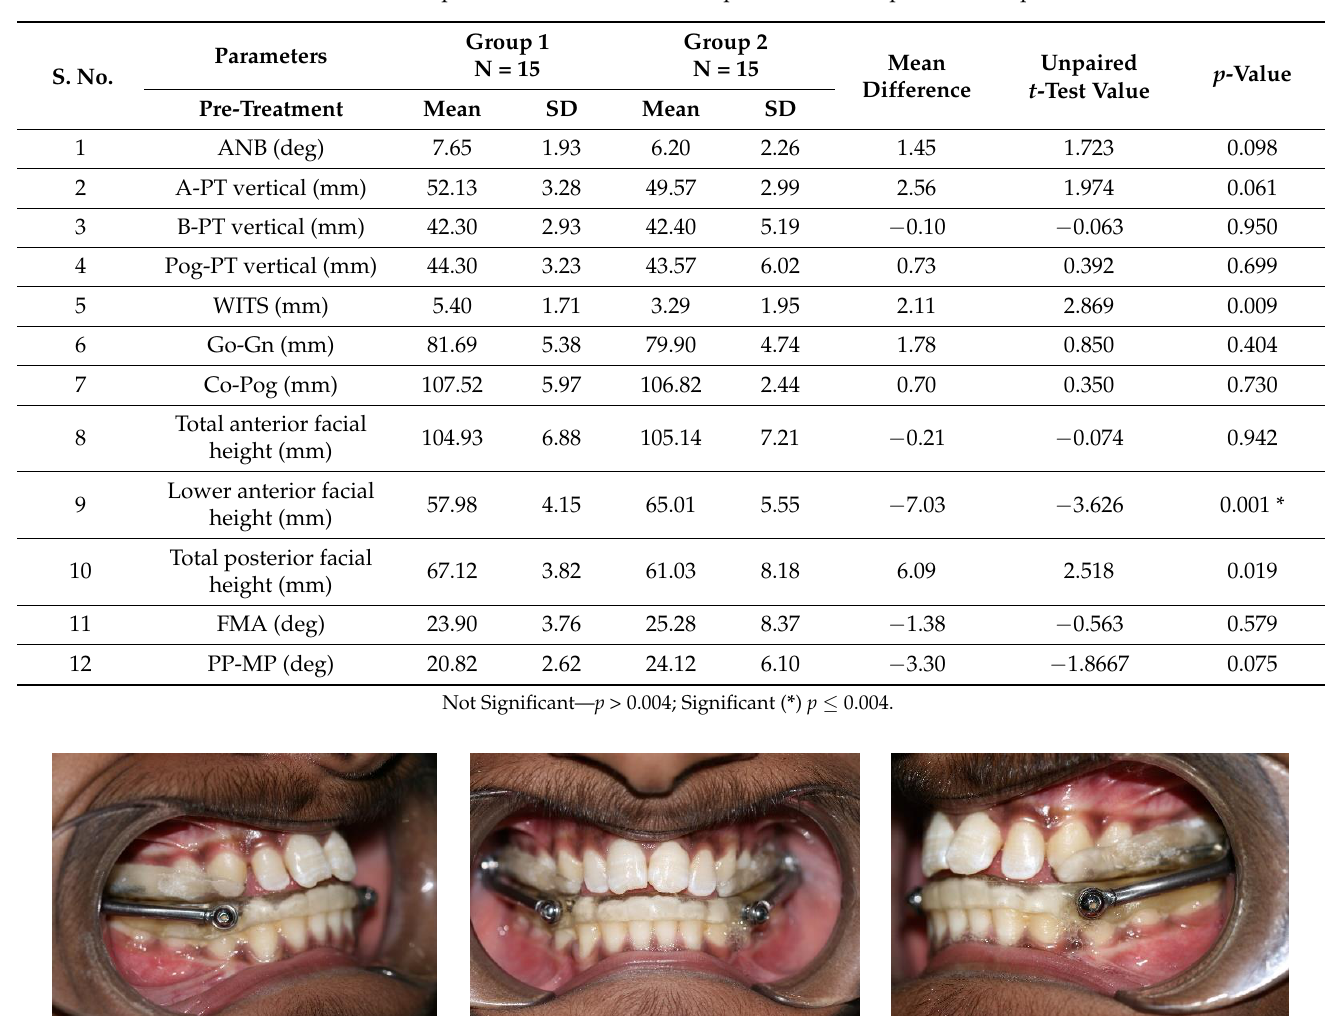
Table 2. Intergroup pretreatment comparison for condyle-glenoid fossa variables. S. No.